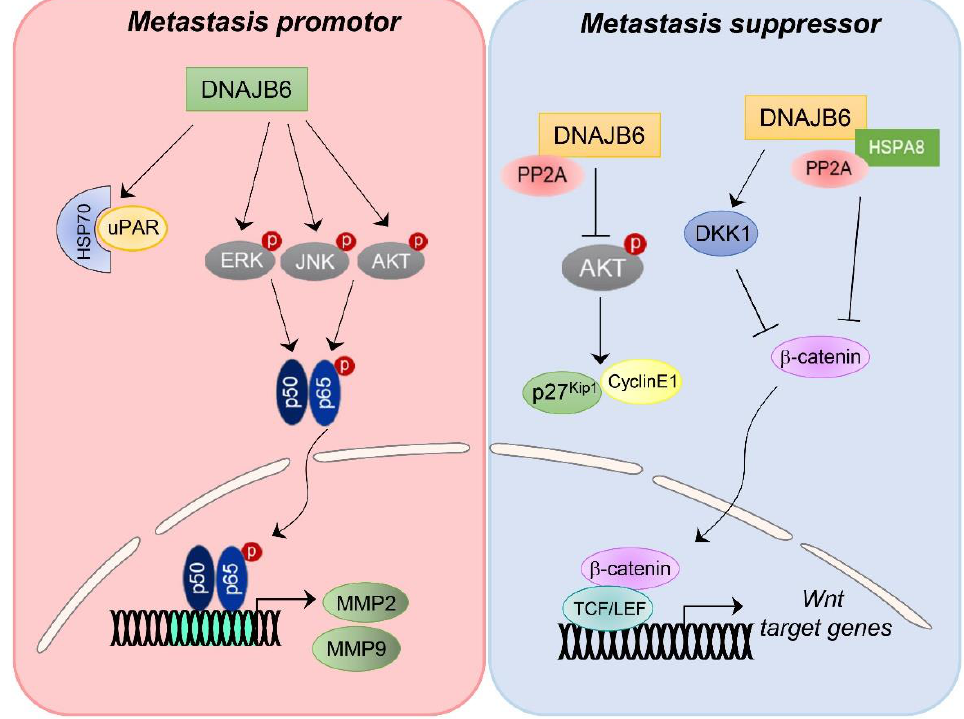
Figure 4. Schematic model showing multi-faceted roles of DNAJB6 in cancer metastasis. DNAJB6 can function as a metastasis promoter or suppressor depending on cancer cell type and context- dependent manner.